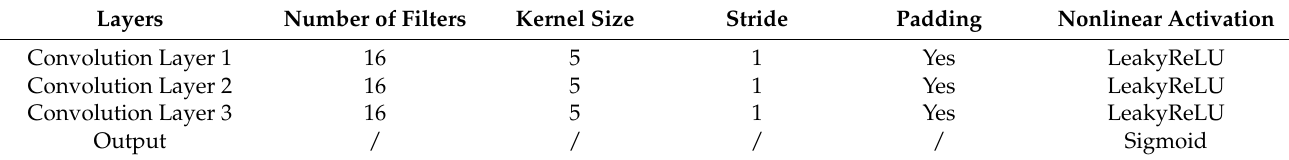
Table 1. The detailed information of sub-models in ensemble convolutional neural network based on attention mechanism (AM-ECNN) for both data